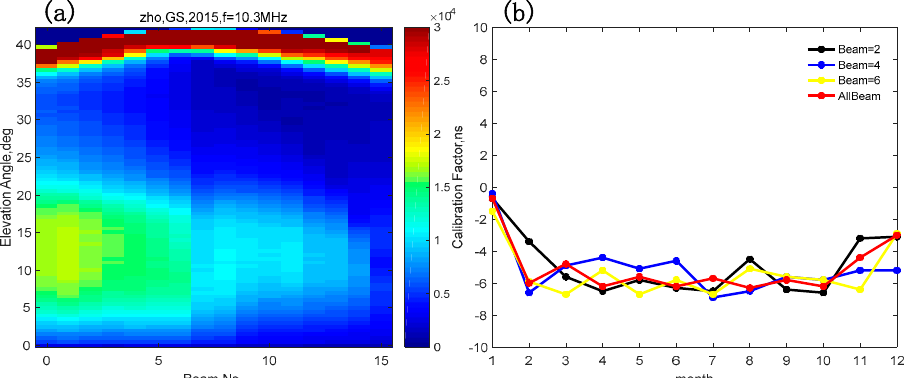
Figure 11. ( a ) The elevation angle ( Red ), the measured phase offset ( yellow ), and the average of two algorithms ( blue ) used to obtain the statistical distribution of the calibration factor. Curve represents the result of Gaussian fitting. ( b ) Two algorithm calibration factor error, black and red dots represent the daily and monthly average changes, respectively.